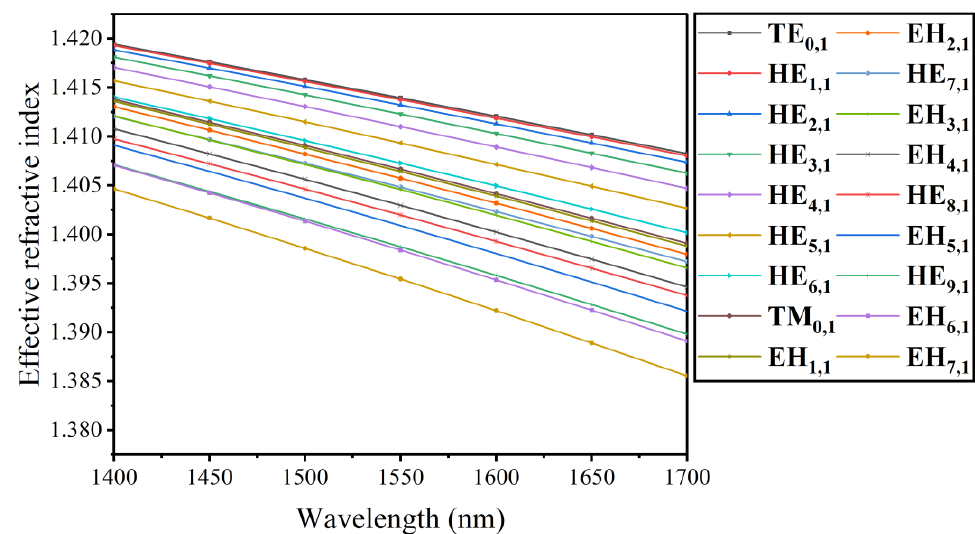
Figure 6. The relation between ERI and wavelength in different vector modes.